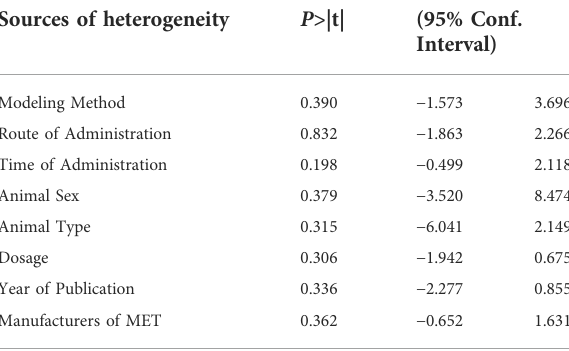
TABLE 2 Meta-regression analysis of the effect of MET on lung tissue fi brosis scores in PF animals. Sources of heterogeneity P >|t| (95% Conf.